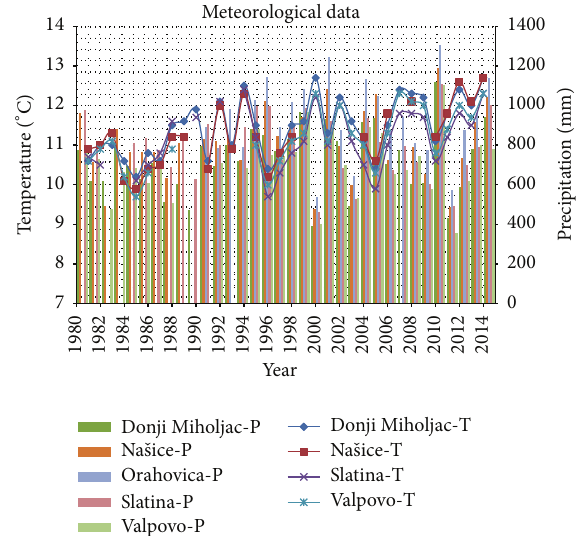
Figure 3: Annual precipitation and mean air temperature.